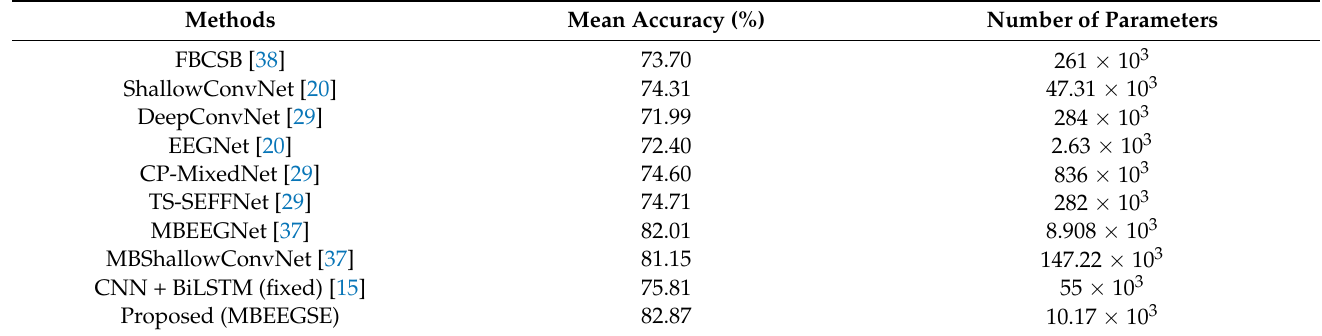
Table 4. Comparison of the number of parameters and mean accuracy using BCI-IV2a